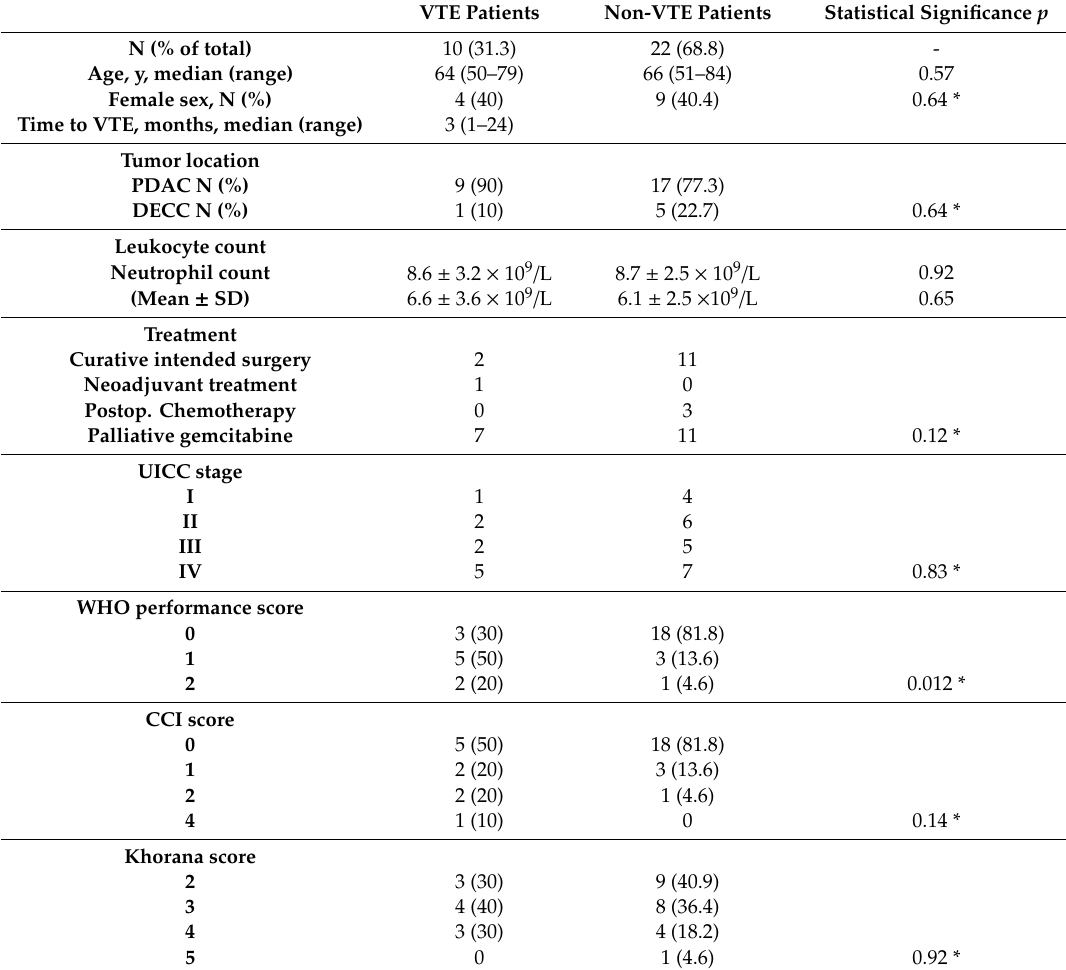
Table 1. Characteristics of the 32 patients with pancreatic ductal adenocarcinoma (PDAC) and distal extrahepatic cholangiocarcinoma (DECC) patients